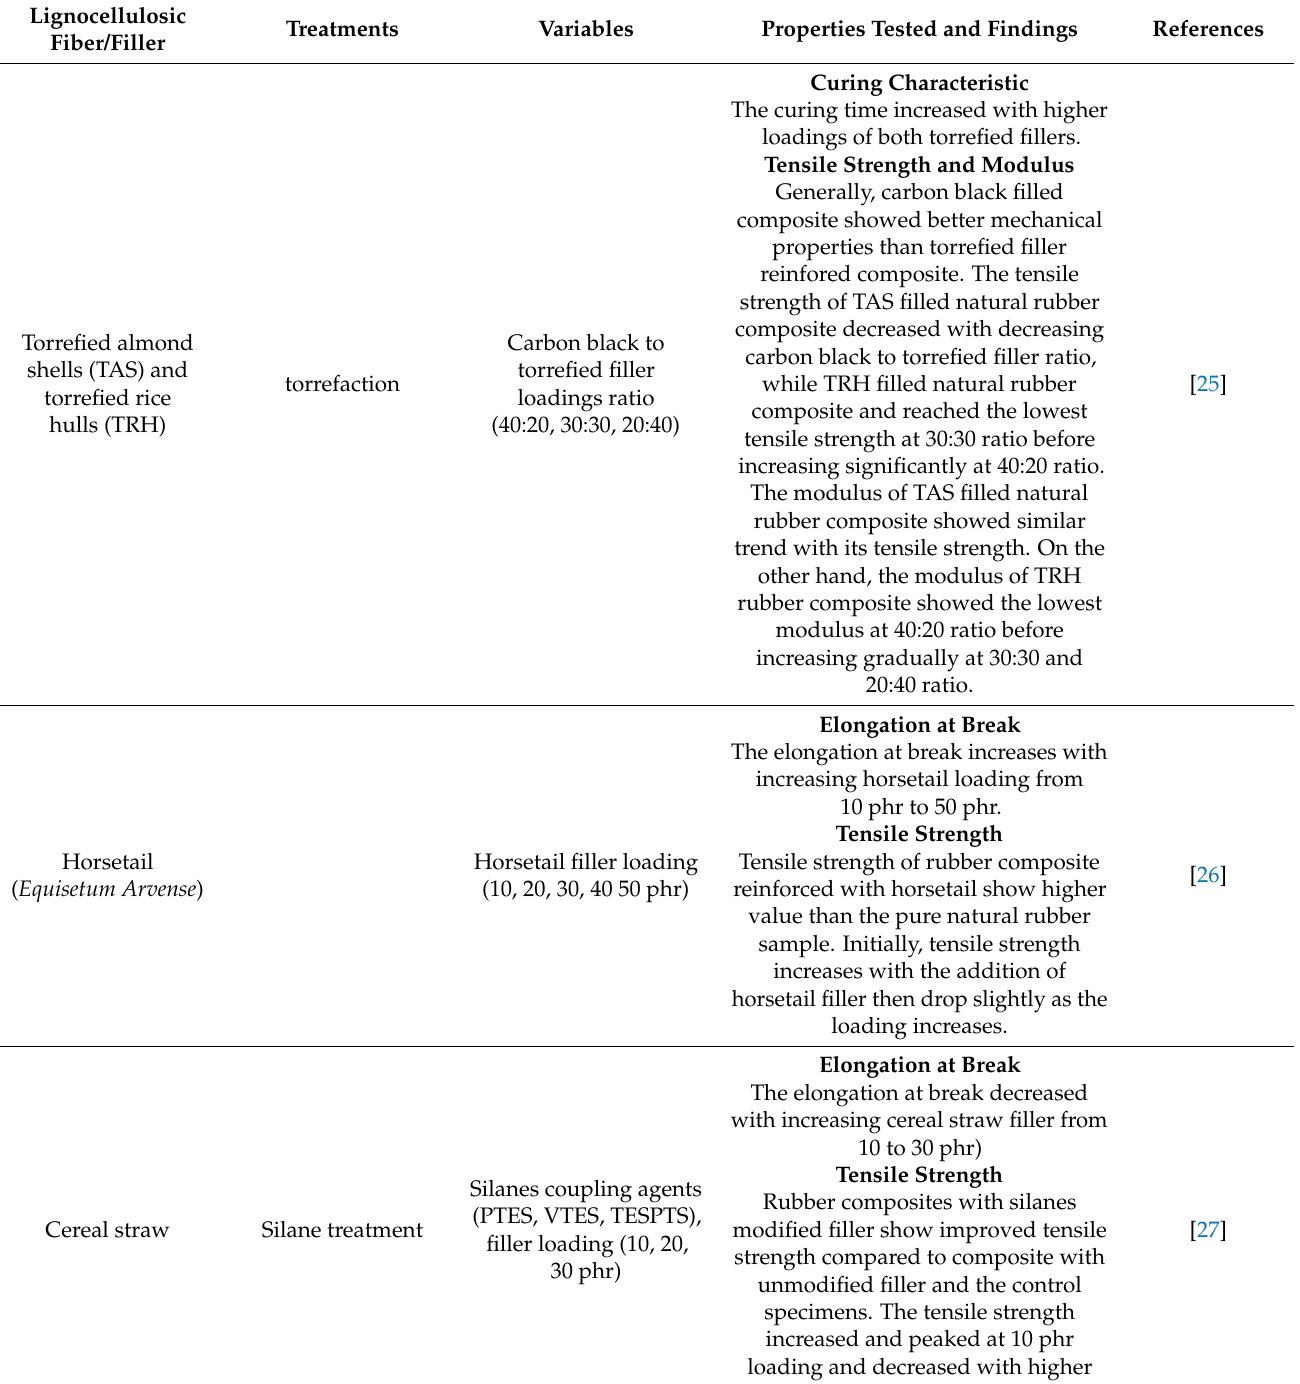
Table 3. The summary of literatures using lignocellulosic fiber as fillers for rubber